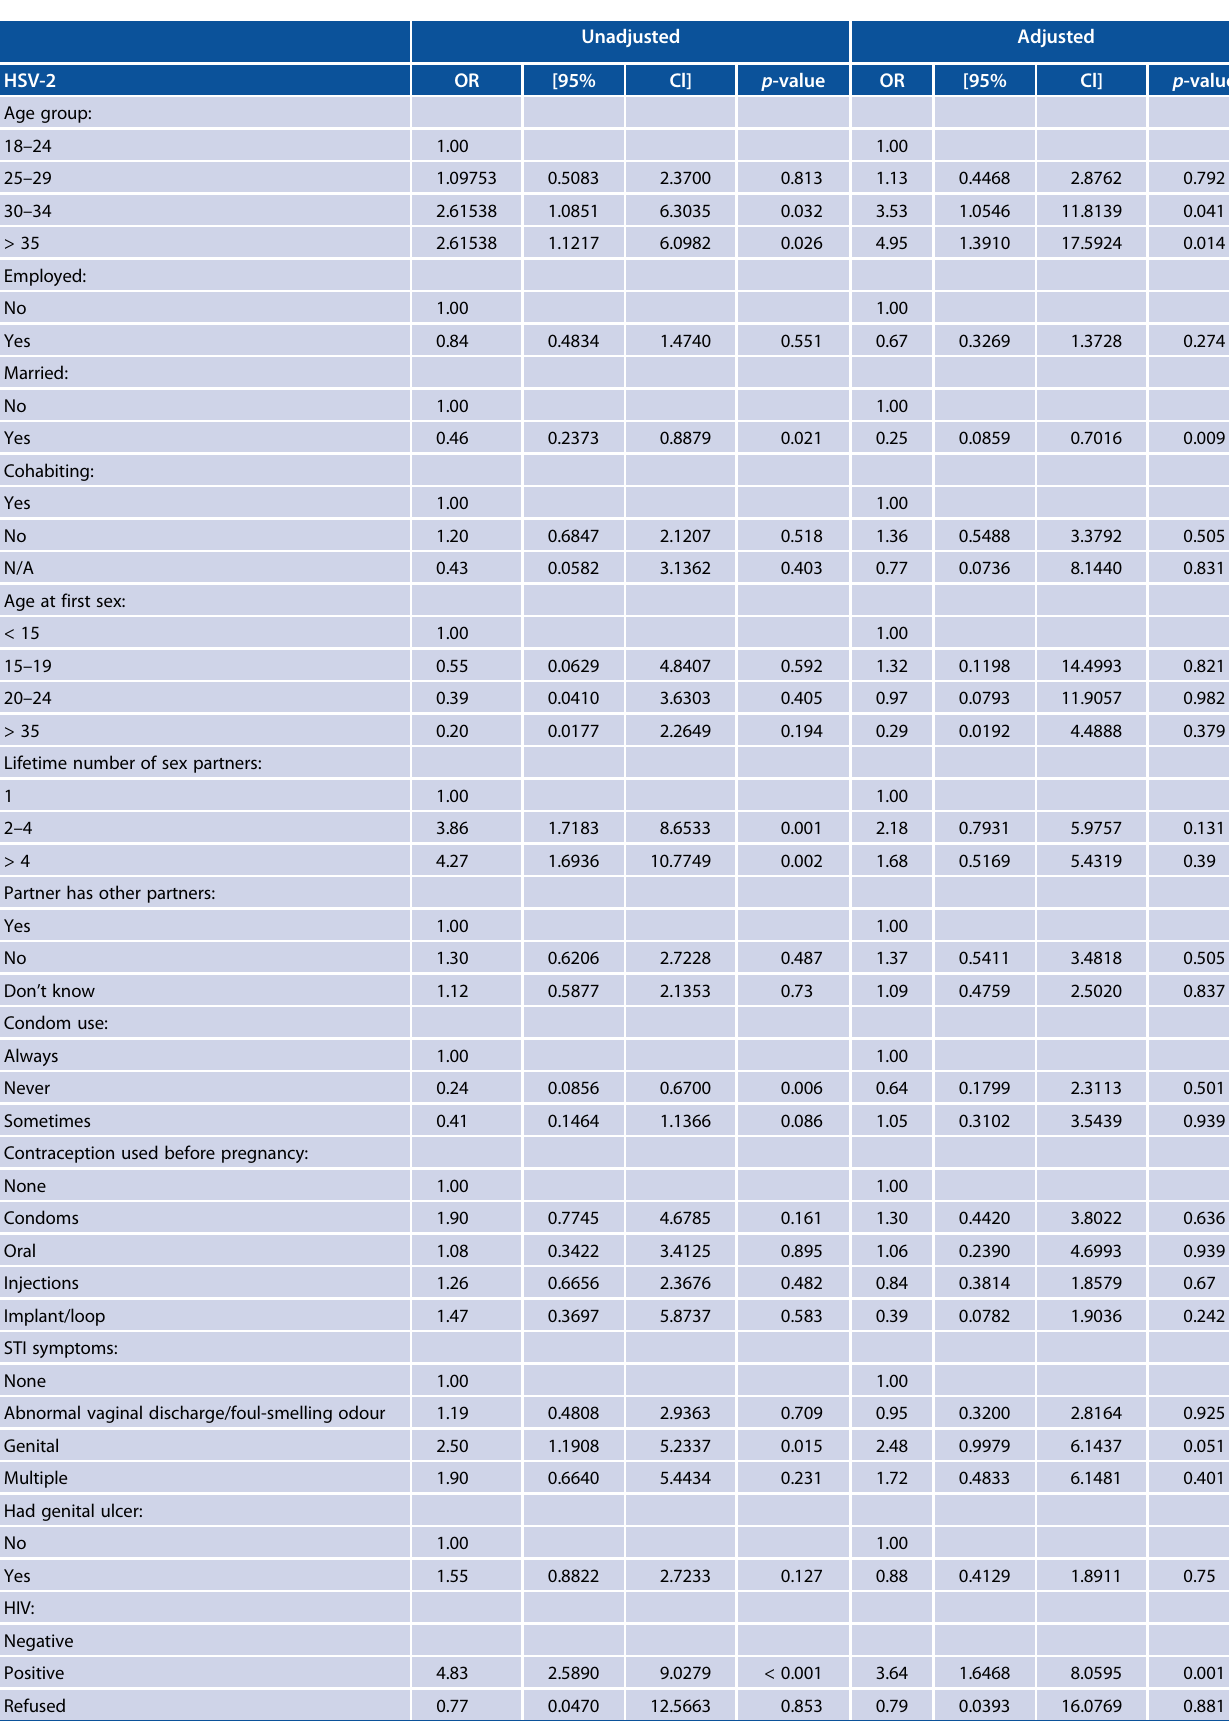
Table 2: Unadjusted and adjusted factors associated with prevalent HSV-2 infections in the pregnant women enrolled in this study from the King Edward VIII